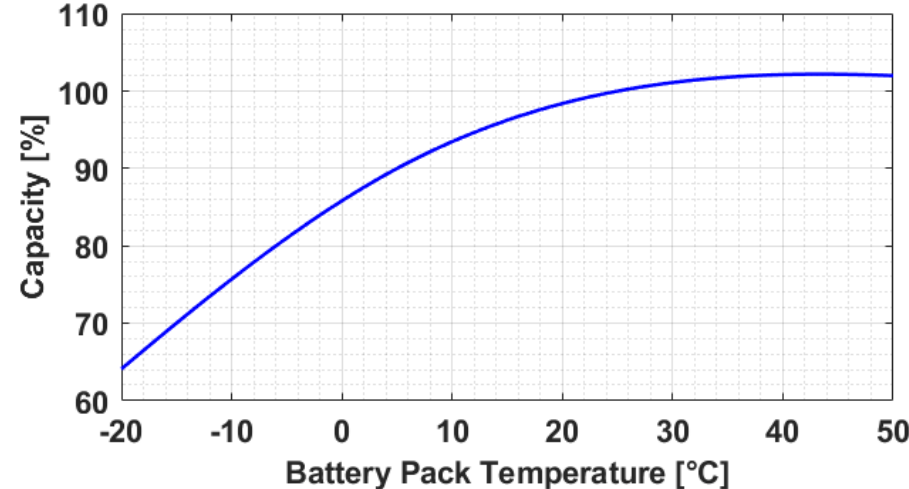
Figure 7. Capacity variation as a function of the battery pack temperature.